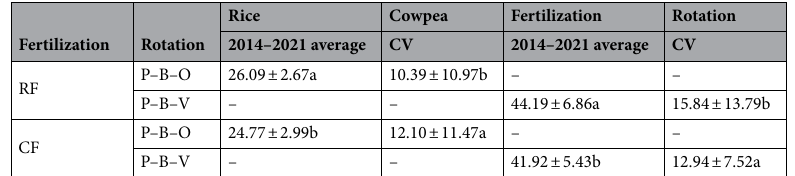
Table 3. Changes in rice and cowpea yield in different years by rotation system for two fertilization modes (kg/plot). Numbers followed by the different letter in a column show significant difference at P < 0.05.